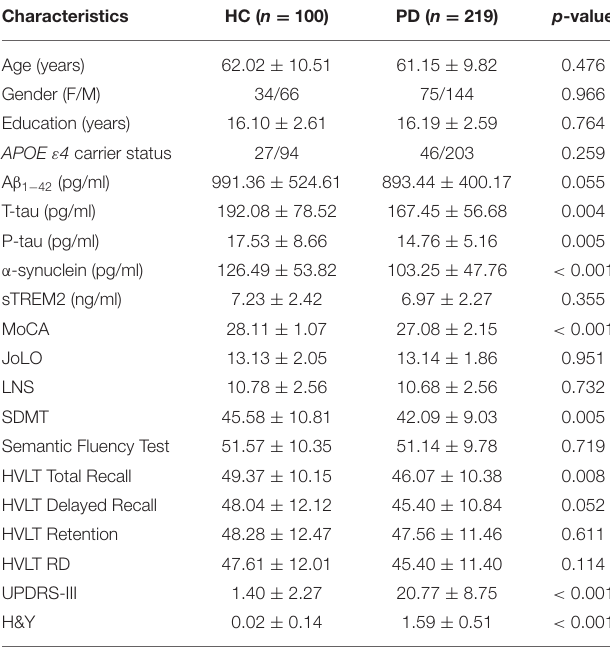
TABLE 1 | Characteristics and CSF biomarkers of participants at